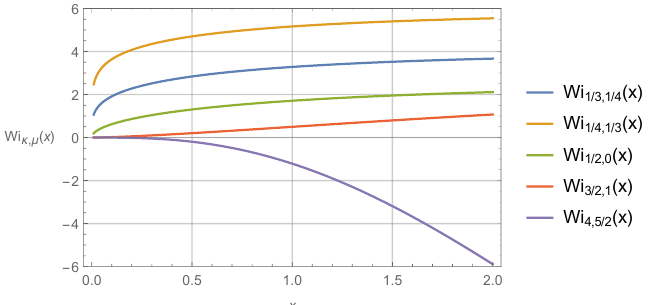
Figure 5. The integral Whittaker functions Wi κ , µ ( x ) as a function of variable x at fixed values of parameters κ and µ .